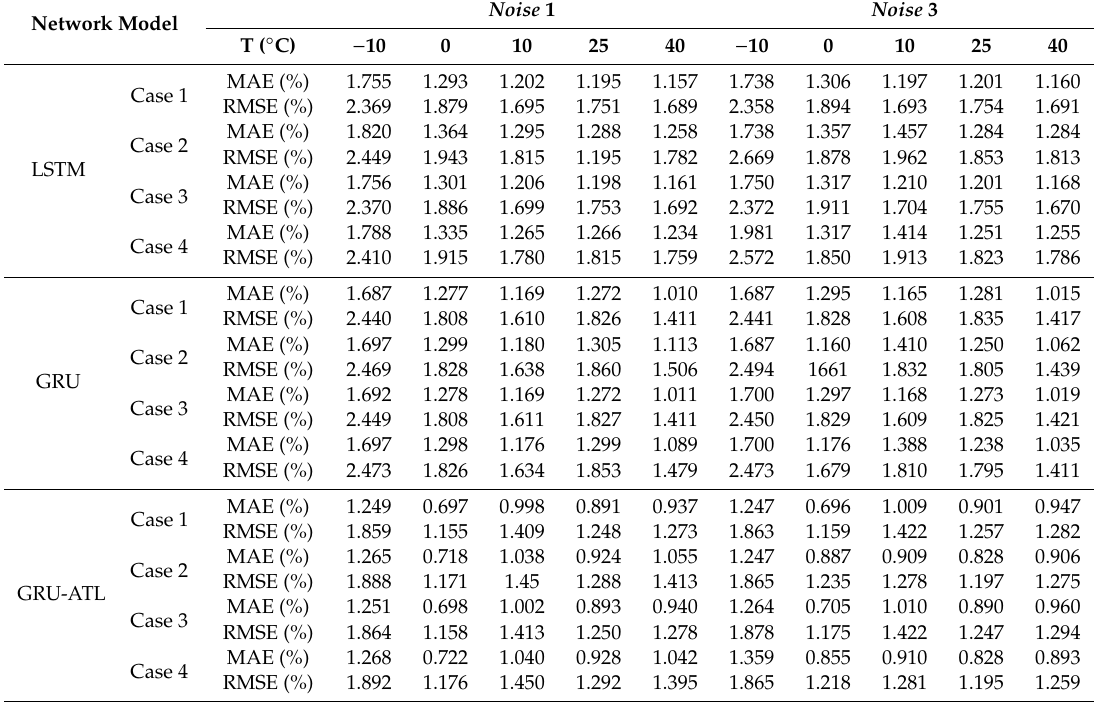
Figure 12. SOC and SOC error of GRU-ATL model in four cases at 40 °C: ( a ) SOC, ( b ) SOC error, ( c ) local enlargement of UDDS, ( d ) local enlargement of LA92. Table 6. The statistical results of SOC error in four